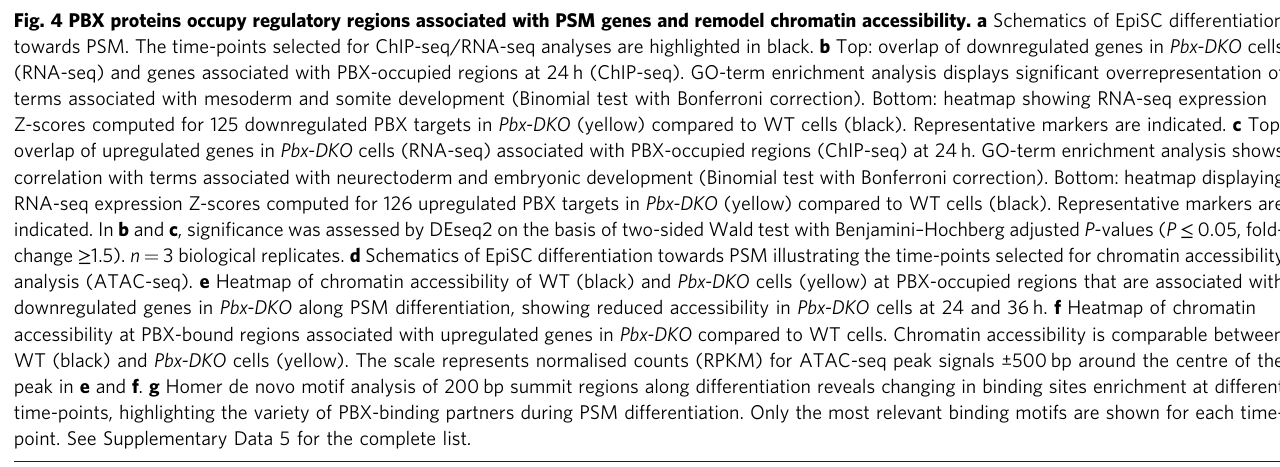
Fig. 4 PBX proteins occupy regulatory regions associated with PSM genes and remodel chromatin accessibility. a Schematics of EpiSC differentiation towards PSM. The time-points selected for ChIP-seq/RNA-seq analyses are highlighted in black. b Top: overlap of downregulated genes in Pbx-DKO cells (RNA-seq) and genes associated with PBX-occupied regions at 24 h (ChIP-seq). GO-term enrichment analysis displays signi fi cant overrepresentation of terms associated with mesoderm and somite development (Binomial test with Bonferroni correction). Bottom: heatmap showing RNA-seq expression Z-scores computed for 125 downregulated PBX targets in Pbx-DKO (yellow) compared to WT cells (black). Representative markers are indicated. c Top: overlap of upregulated genes in Pbx-DKO cells (RNA-seq) associated with PBX-occupied regions (ChIP-seq) at 24 h. GO-term enrichment analysis shows correlation with terms associated with neurectoderm and embryonic development (Binomial test with Bonferroni correction). Bottom: heatmap displaying RNA-seq expression Z-scores computed for 126 upregulated PBX targets in Pbx-DKO (yellow) compared to WT cells (black). Representative markers are indicated. In b and c , signi fi cance was assessed by DEseq2 on the basis of two-sided Wald test with Benjamini – Hochberg adjusted P- values ( P ≤ 0.05, fold- change ≥ 1.5). n = 3 biological replicates. d Schematics of EpiSC differentiation towards PSM illustrating the time-points selected for chromatin accessibility analysis (ATAC-seq). e Heatmap of chromatin accessibility of WT (black) and Pbx-DKO cells (yellow) at PBX-occupied regions that are associated with downregulated genes in Pbx-DKO along PSM differentiation, showing reduced accessibility in Pbx-DKO cells at 24 and 36 h. f Heatmap of chromatin accessibility at PBX-bound regions associated with upregulated genes in Pbx-DKO compared to WT cells. Chromatin accessibility is comparable between WT (black) and Pbx-DKO cells (yellow). The scale represents normalised counts (RPKM) for ATAC-seq peak signals ±500 bp around the centre of the peak in e and f . g Homer de novo motif analysis of 200 bp summit regions along differentiation reveals changing in binding sites enrichment at different time-points, highlighting the variety of PBX-binding partners during PSM differentiation. Only the most relevant binding motifs are shown for each time- point. See Supplementary Data 5 for the